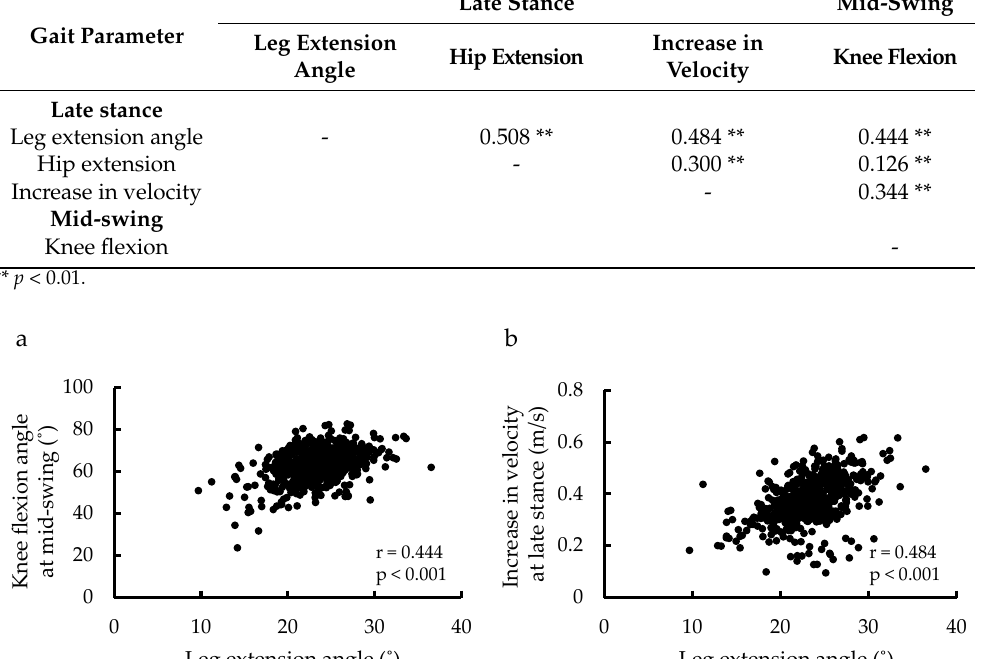
Figure 4. Scatter plot of leg extension angle, knee joint angle, and increase in velocity. Relationships between leg extension angle and knee flexion angle at mid-swing ( a ), and between leg extension angle and increase in velocity at late stance ( b ). Table 2. Multiple regression analysis of knee flexion angle at mid-swing and gait parameters at late stance.